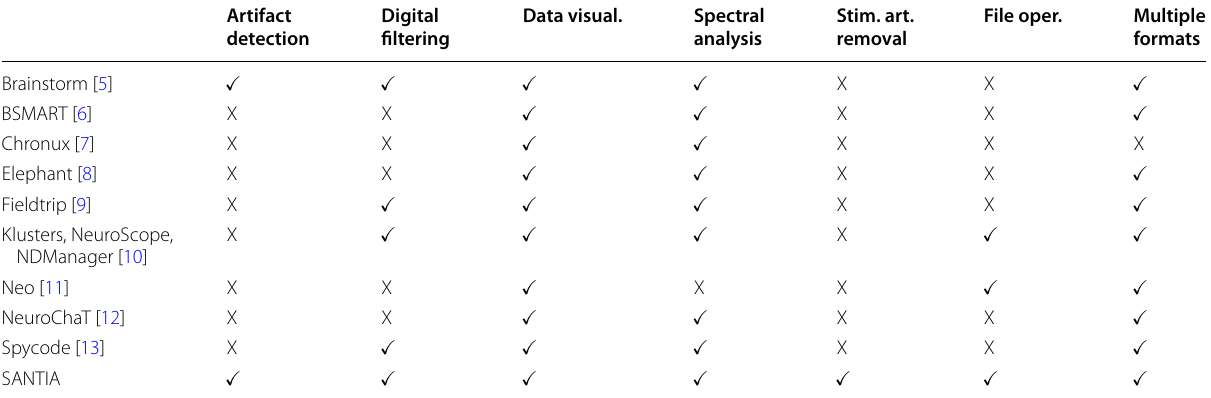
Data visualization, stimulation artifact removal and file operations (i.e., file splitting, concatenation, column rearranging)